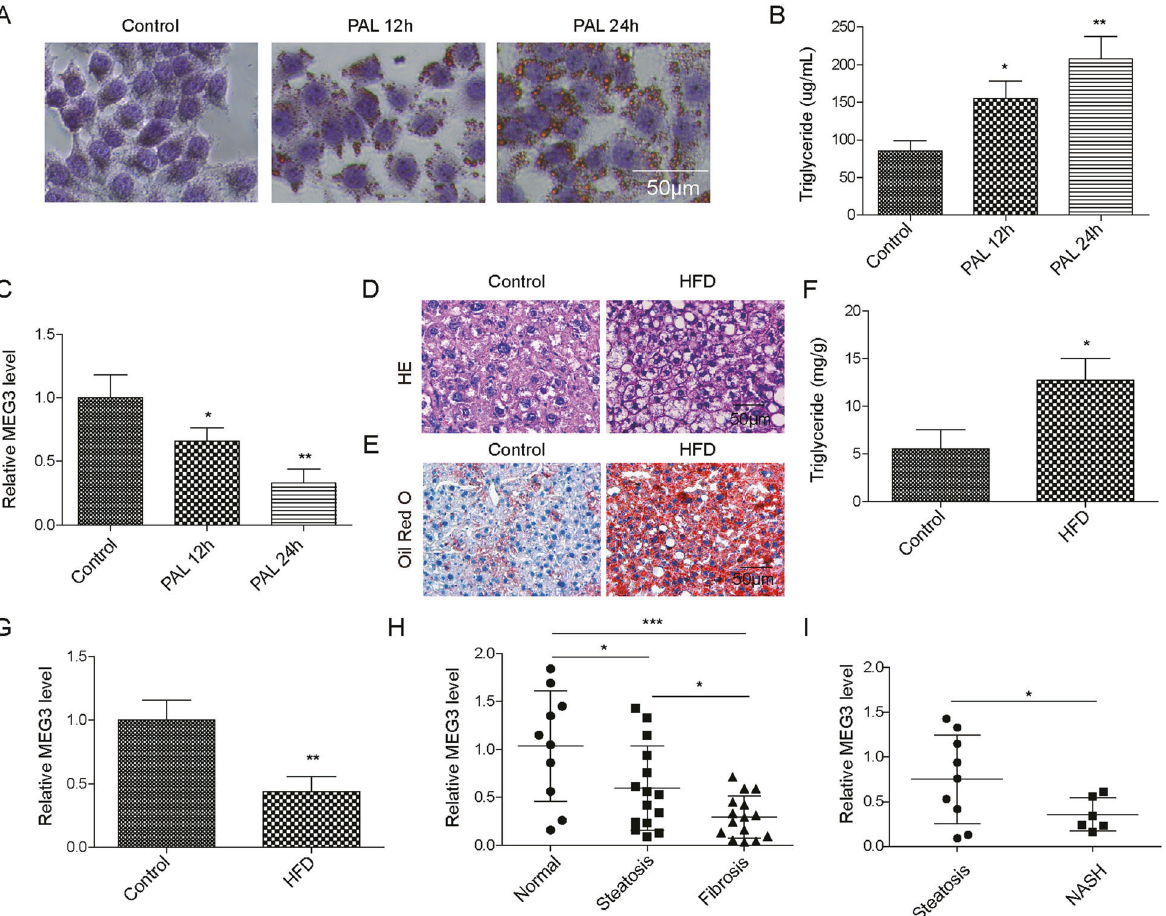
was examined by RT-qPCR. D – G Mice were fed with HFD for 12 weeks to induce NAFLD. Mice fed with normal diet were used as control. HE staining ( D ) and Oil Red O staining ( E ) of liver tissues from indicated groups. F Triglyceride level from the liver tissue was measured. G MEG3 expression in liver tissue was examined by RT-qPCR. H RT-qPCR was performed to measure MEG3 expression from normal livers ( n = 10), livers with steatosis ( n = 15), and those with fi brosis ( n = 15). I RT-qPCR was performed to measure MEG3 expression from patients diagnosed with simple steatosis ( n = 9) and those from patients with NASH ( n = 6). * P < 0.05, ** P <